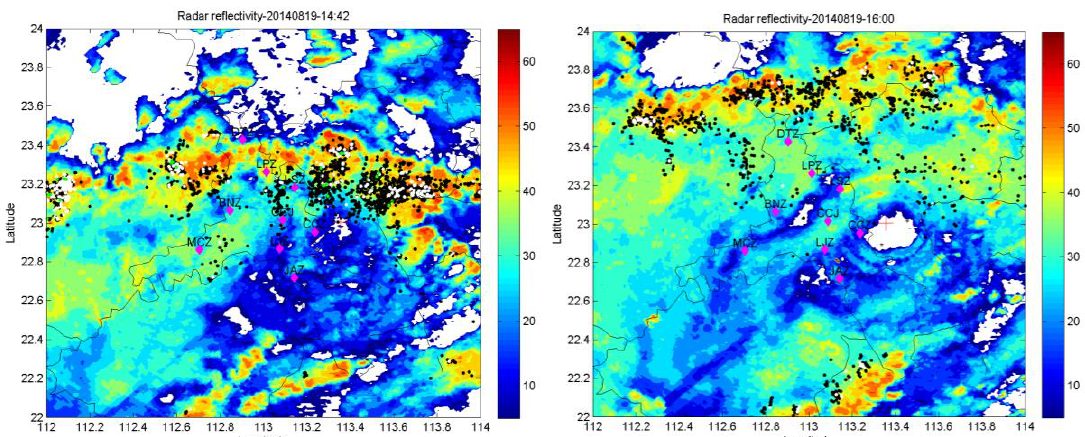
Figure 15. Reflectivity scan by DSR research radar for a storm cell on 19 August 2014. Prominent areas of higher reflectivity exhibit dominant IC events (black dots), CG strokes (red dots), and NBE (white dots), respectively. The radar station (red plus) is situated on the east side of the network (red diamond).